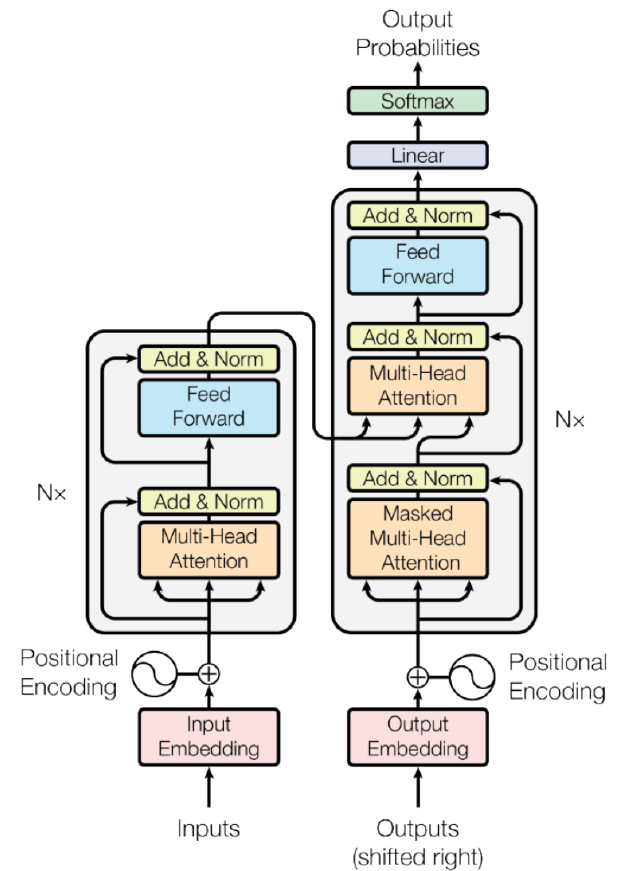
Figure 2. The Transformer Model architecture